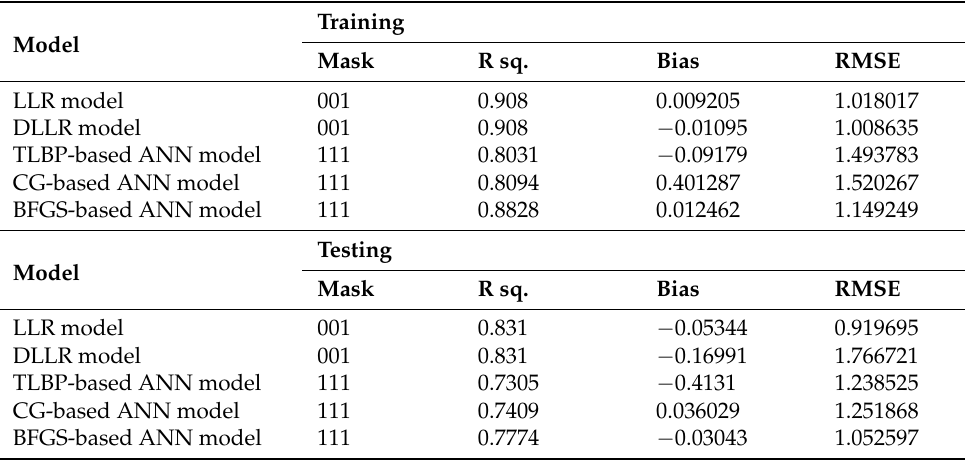
Figure 5. Best DLLR-based models (training and testing). Table 4. Comparison of selected input combinations (training and testing).